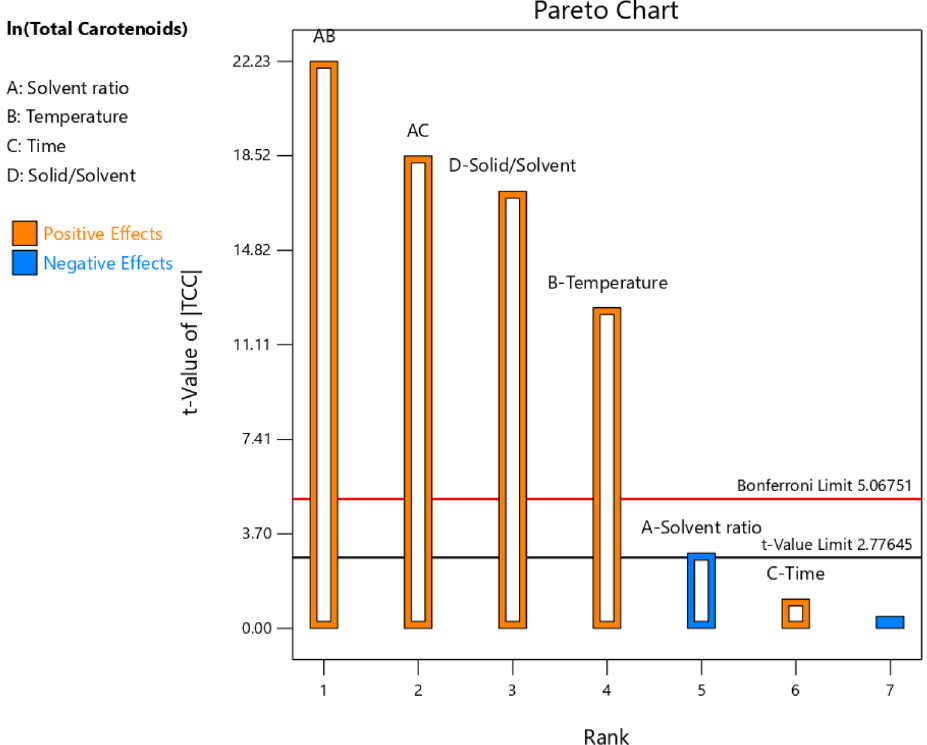
Figure 2. Pareto chart representation for the effect of different factors on Total carotenoids and antioxidant